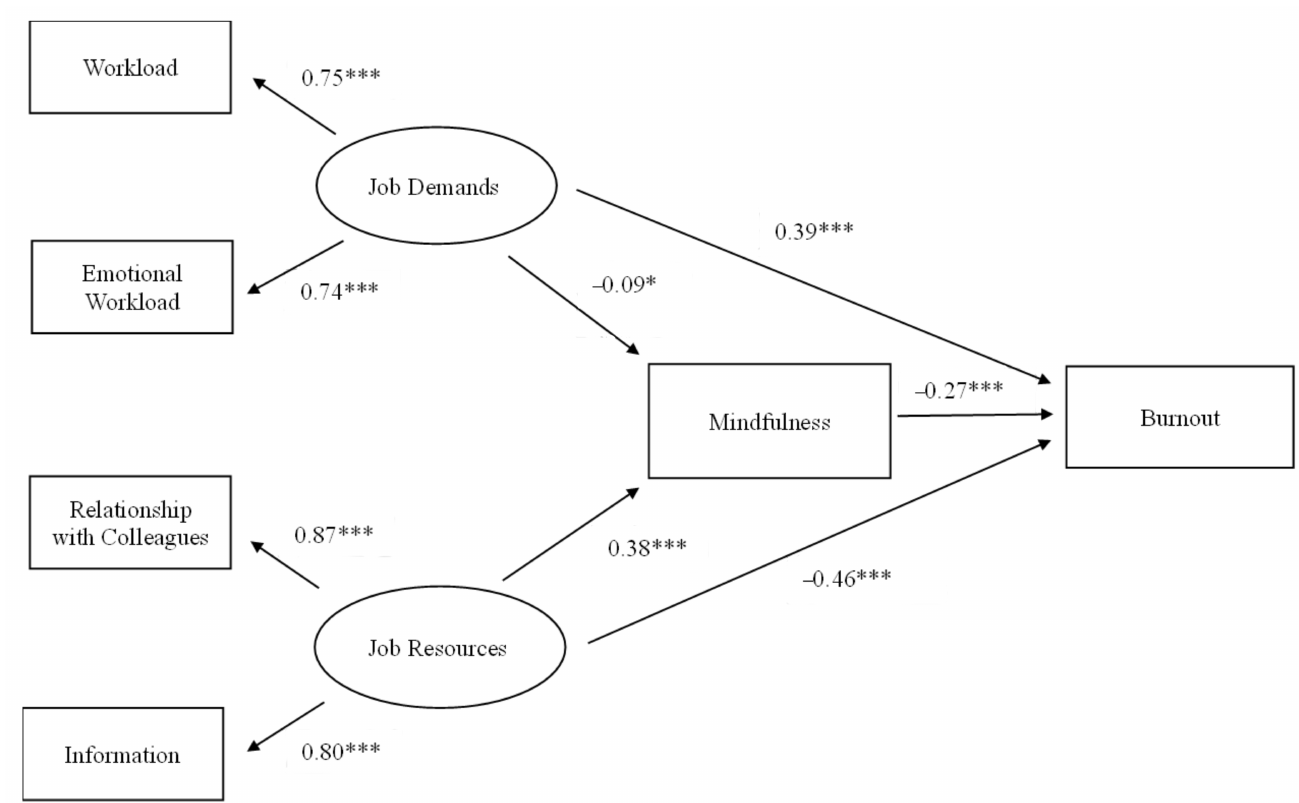
Figure 2. Standardized estimates of JD-R, mindfulness, and burnout model. * p < 0.05, *** p <